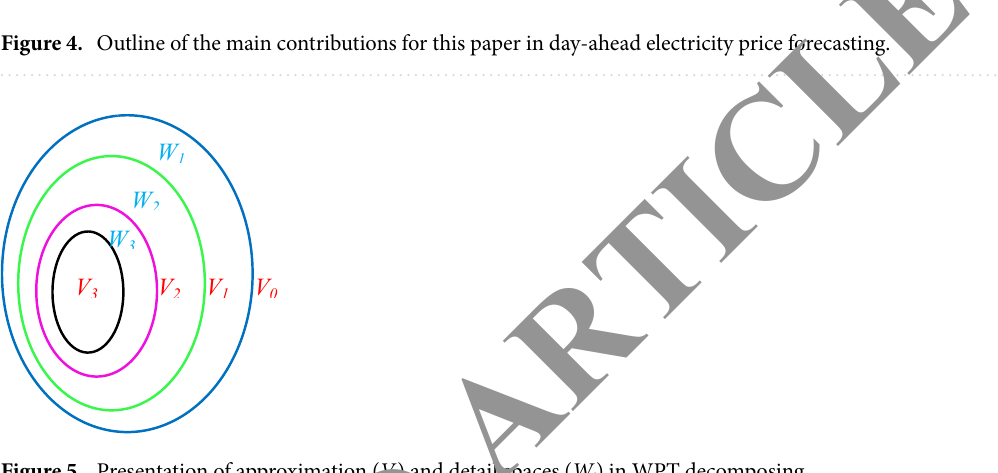
Figure 5. Presentation of approximation ( V j ) and detail spaces ( W j ) in WPT